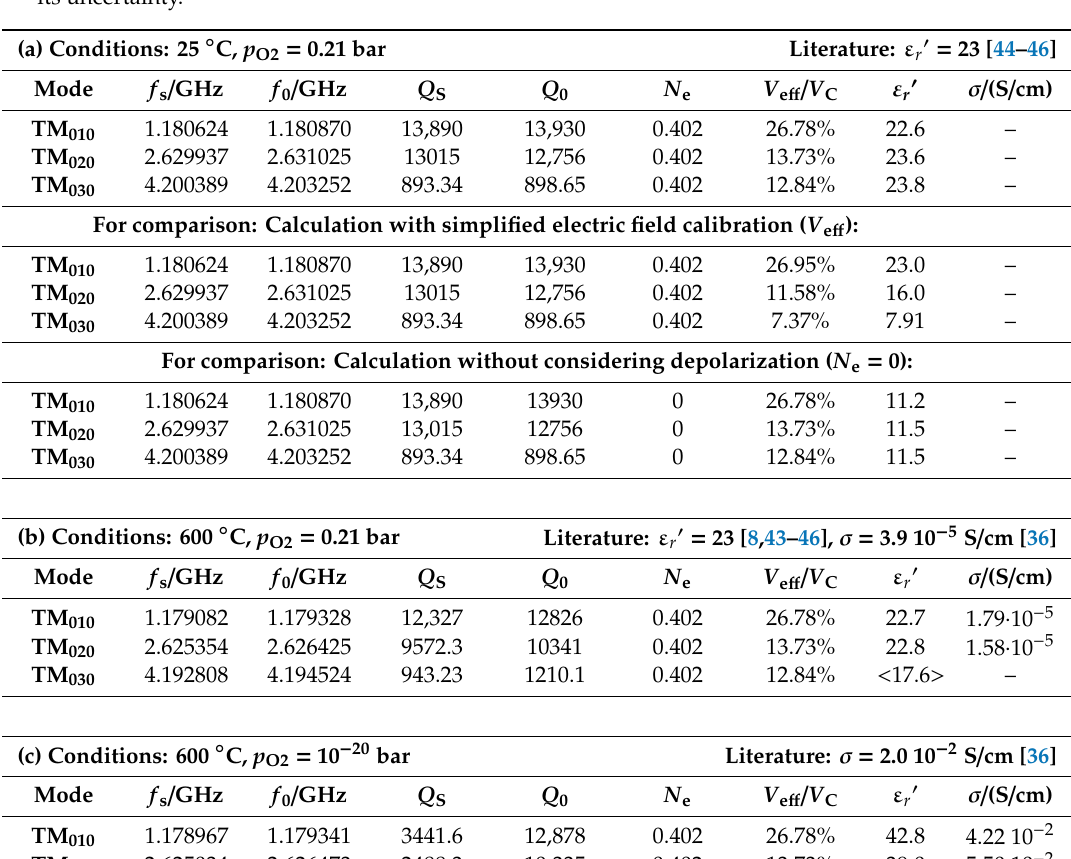
Table 4. Results for the dielectric properties of the ceria sample inside the resonator cavity: (a) measured at 25 ◦ C and 21% O 2 ; (b) at 600 ◦ C and 21% O 2 ; (c) at 600 ◦ C and p O2 = 10 − 20 bar. The derived values for the material permittivity are highlighted. Please note the lower permittivity for higher modes when applying simplifications. The permittivity for the TM 030 mode in (b) is written in brackets, due to its